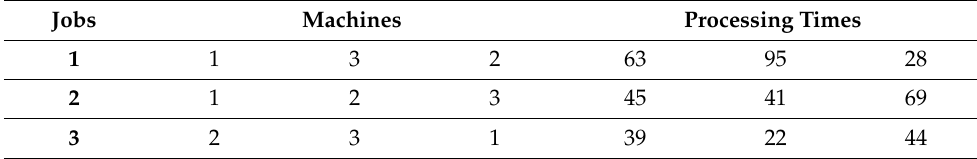
Table 1. The machine and processing time of each operation of the